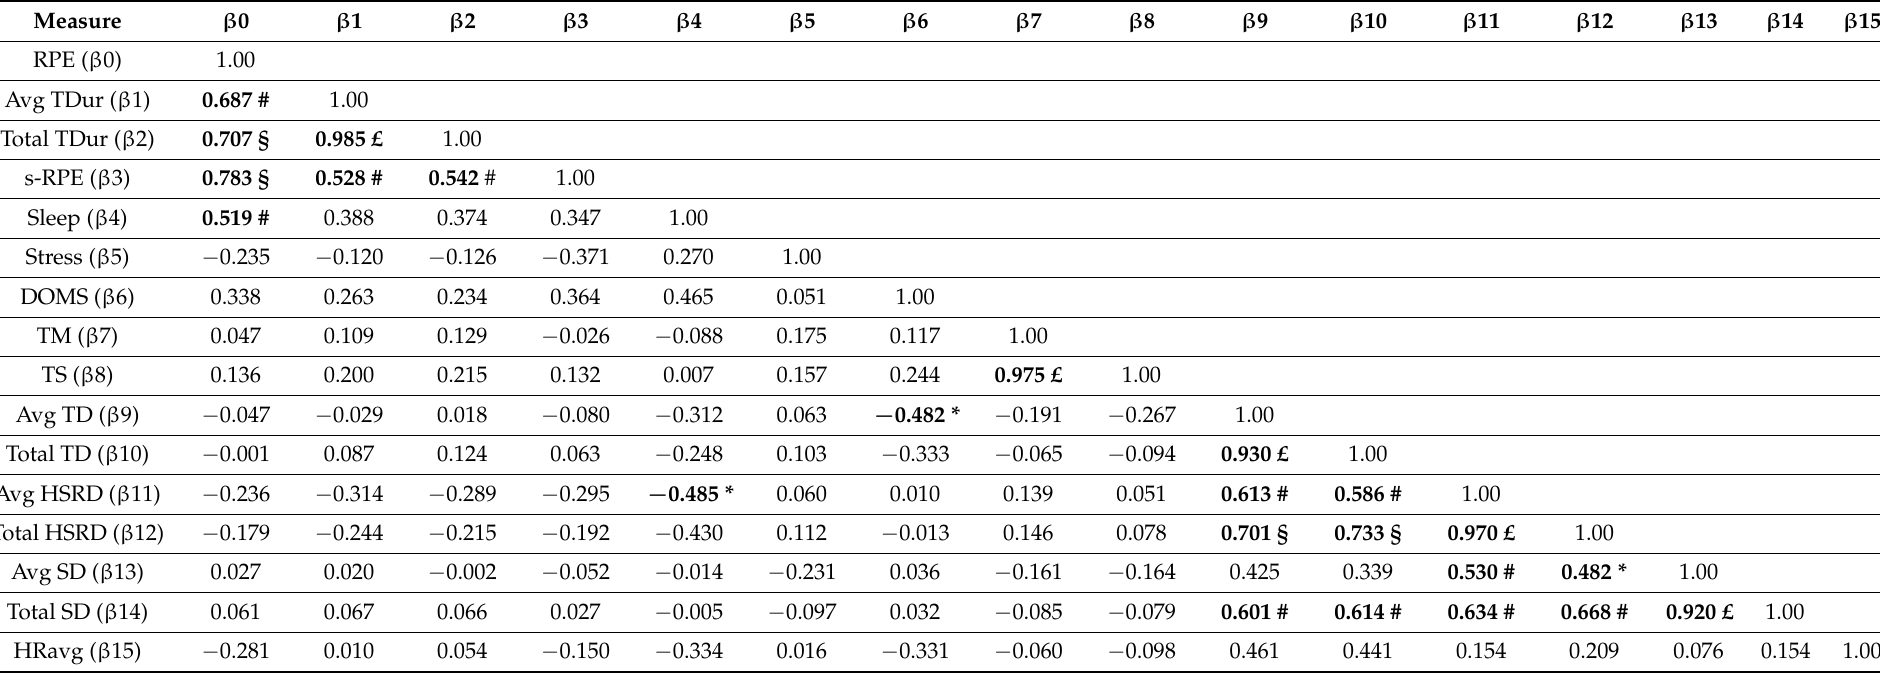
Table 2. Correlation analysis between the measures in study on the